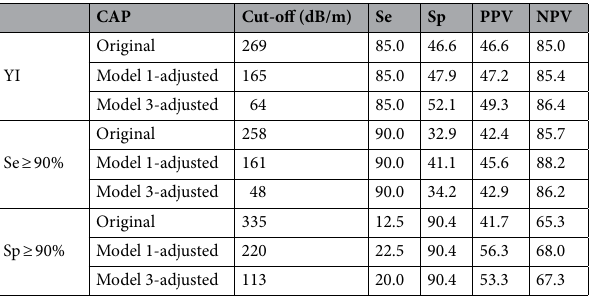
Table 5. Cut-off values of original and modified CAP for detecting steatosis score of ≥ 2. All values are shown as percentages. Abbreviations: CAP, controlled attenuation parameter; YI, Youden’s index; Se, sensitivity; Sp,